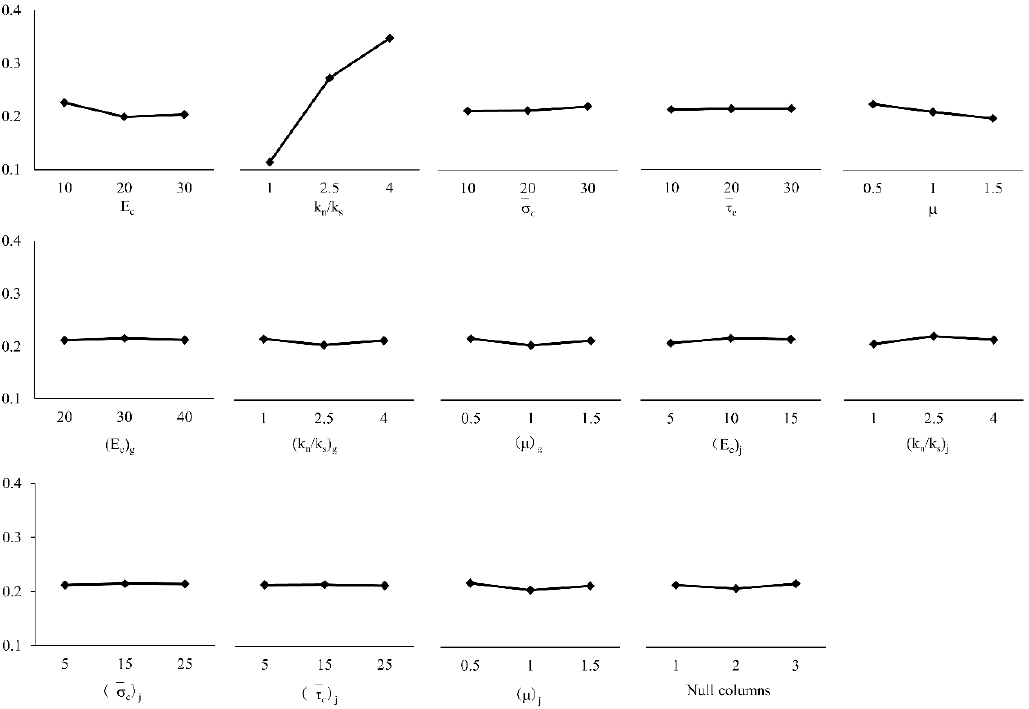
Figure 7. Mean value of Poisson’s ratio.